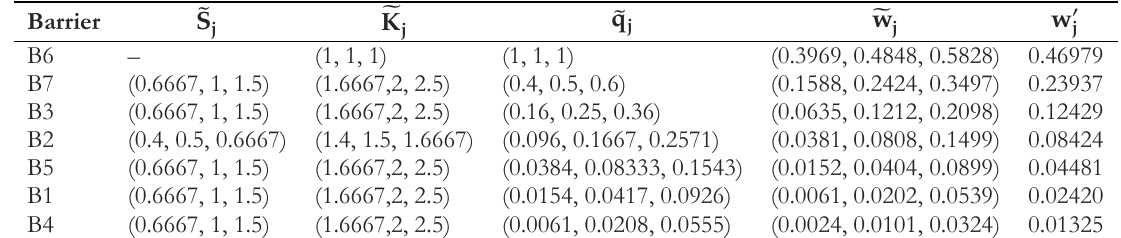
Table 7. Fuzzy SWARA results for DM1 and main barriers